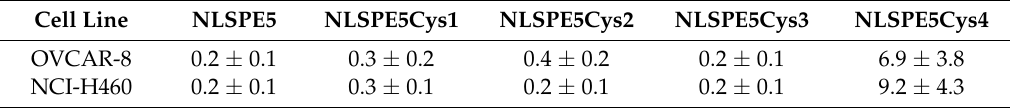
Table 4. IC 50 values ( µ M) of the different ND-RNases on OVCAR-8 and NCI-H460 cell lines. Cell Line